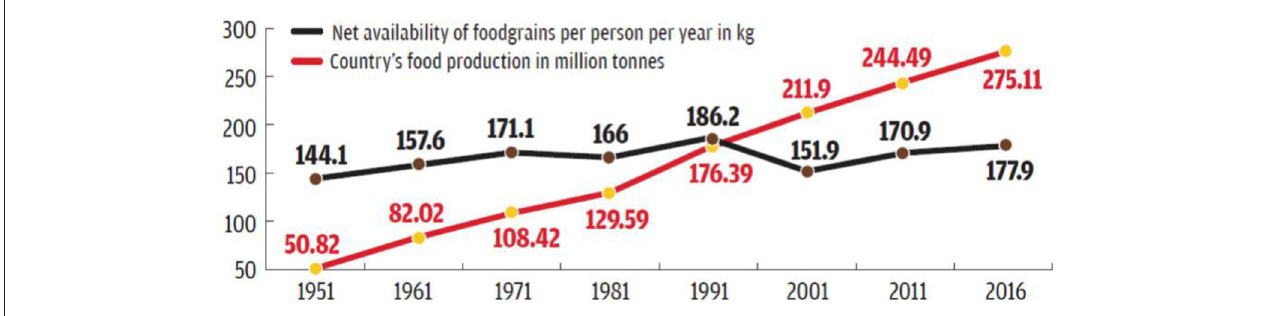
FIGURE 3 | Trends in food grain production and per capita availability in India. Adapted from: Agriculture Statistic, Ministry of Agriculture and Family Welfare. and their regulating pathways (Hrdlickova et al., 2017).